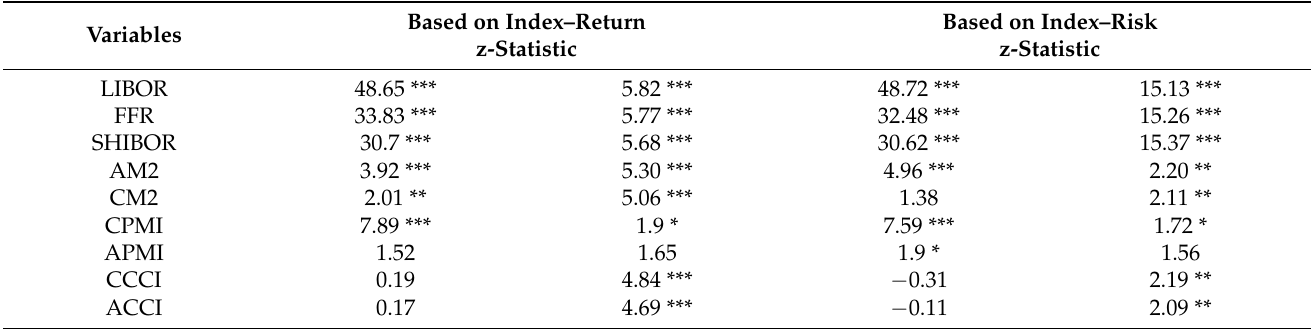
Table 6. BDS test on the residual series of the bivariate VAR models.